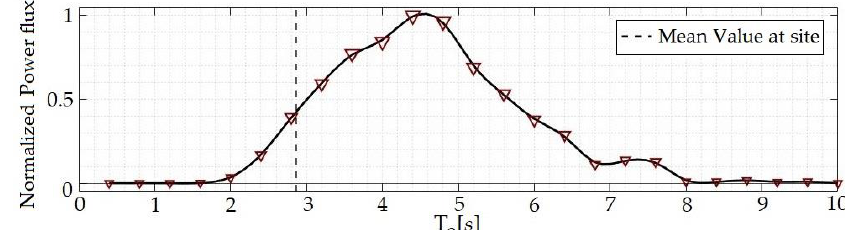
Figure 15. Distribution of the available wave energy at TP as a function of the incident wave period.